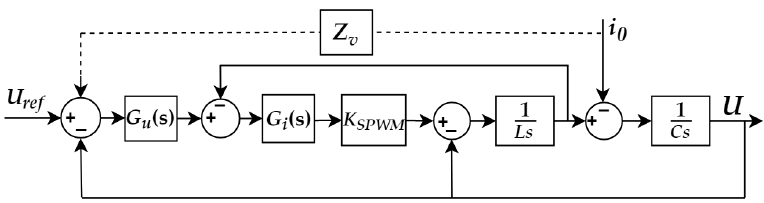
Figure 7. Voltage and current double loop control link with virtual impedance.